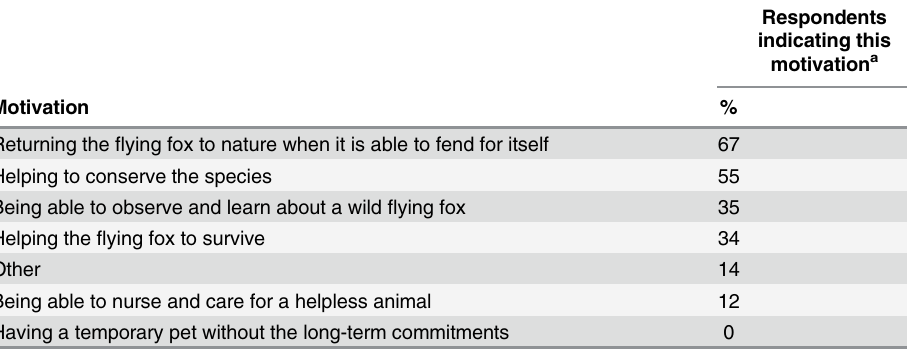
Table 2. Motivations of 122 Australian flying fox rehabilitators,